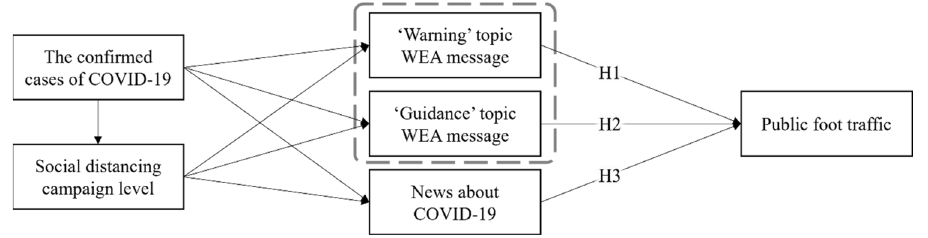
Figure 1. Path model with hypotheses for public foot